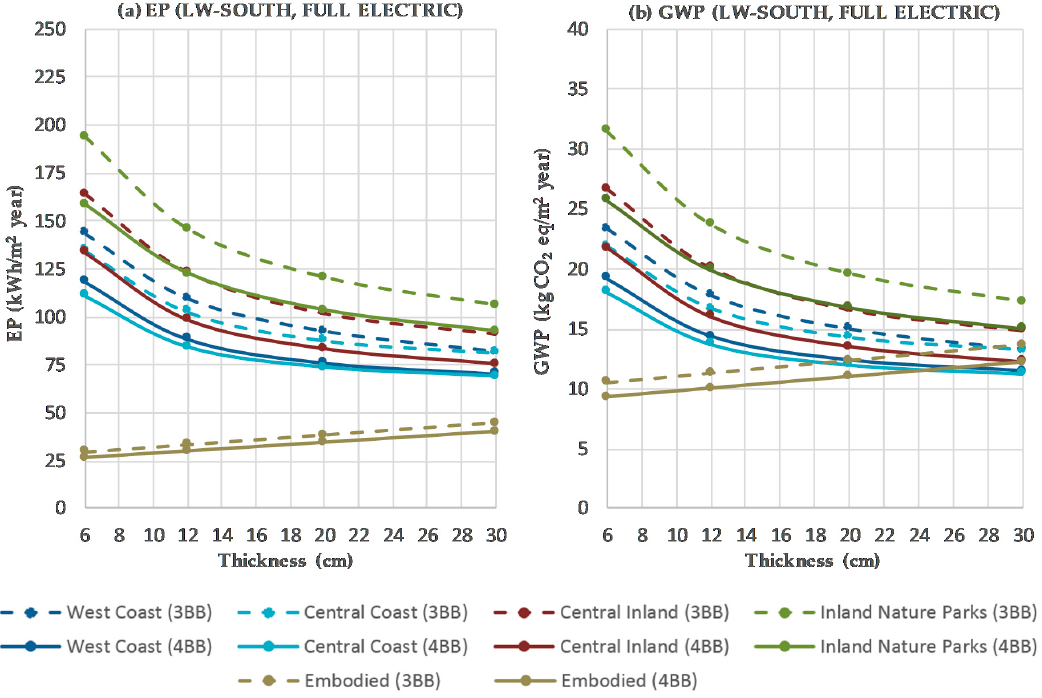
Figure 8. Embodied and use impacts of primary energy and CO 2 equivalent emissions for the electricity-only scenario, depending on insulation thickness, for the four locations, with LW-SOUTH both for 4BB and 3BB.